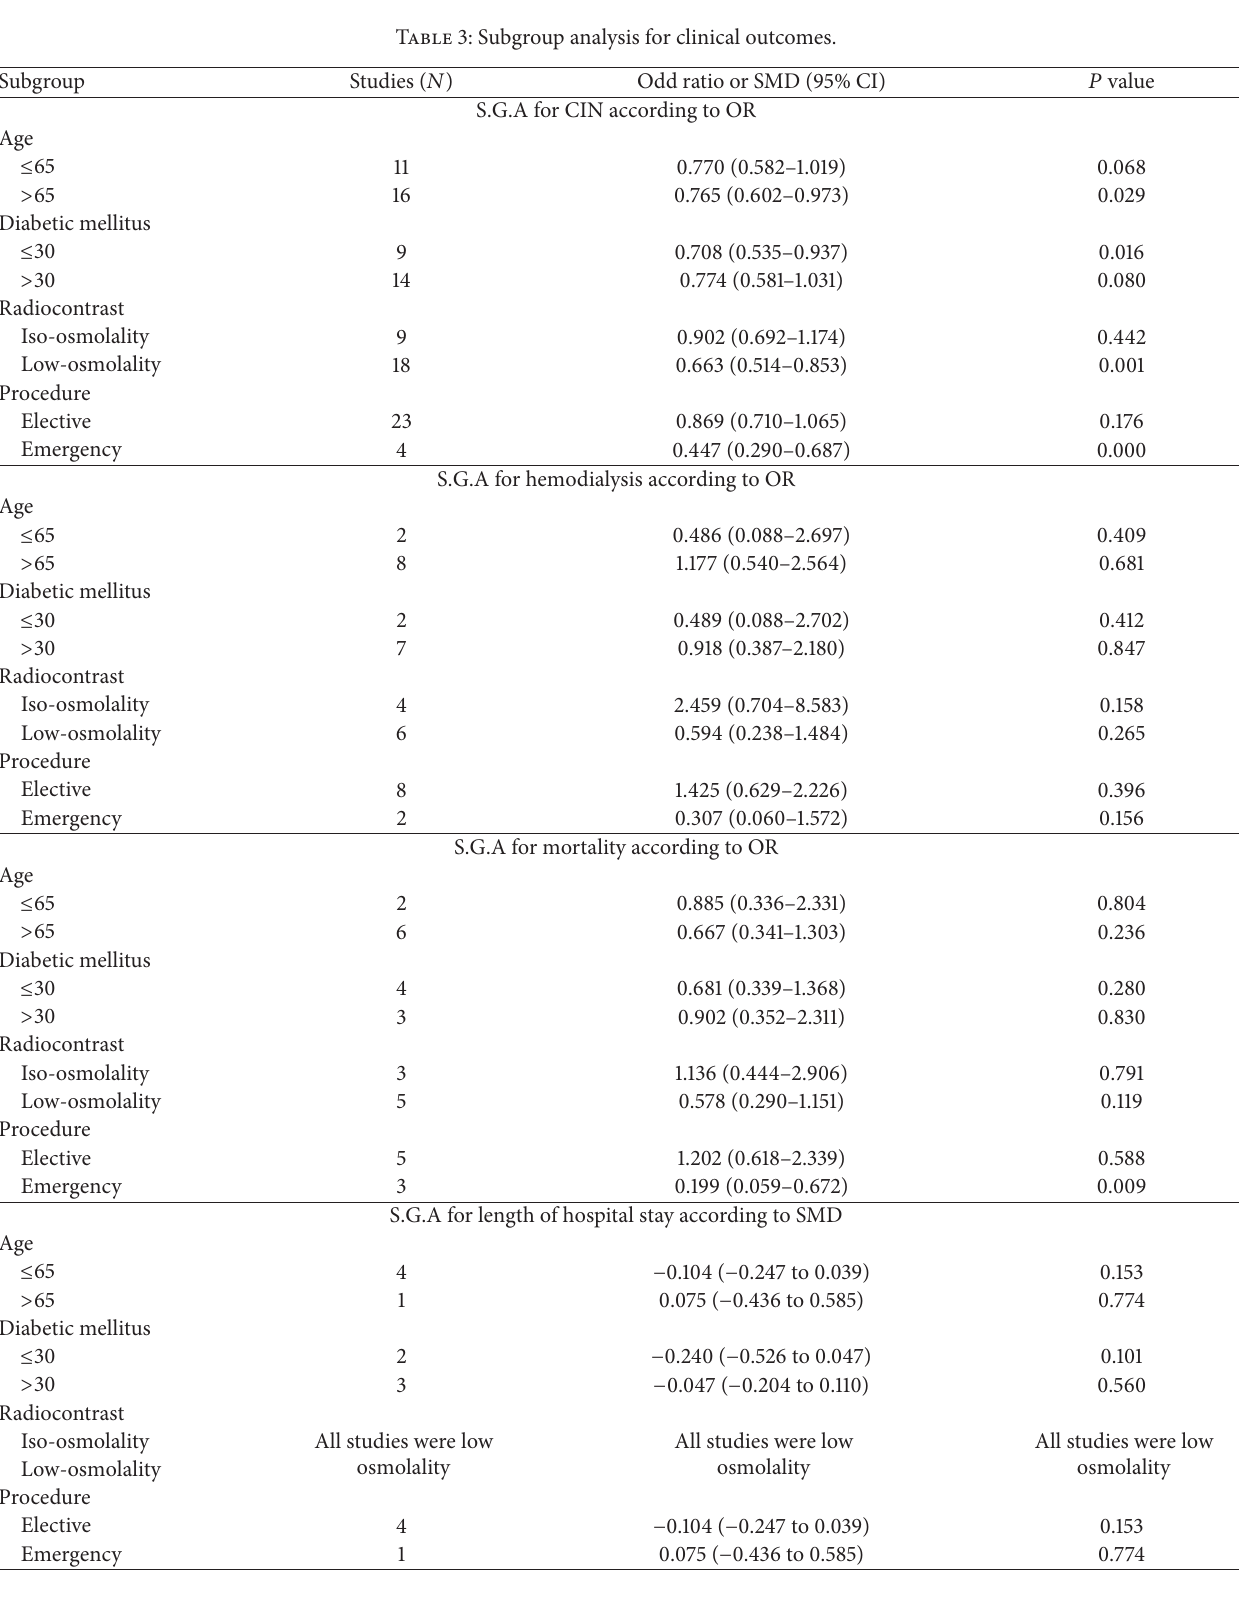
Table 3: Subgroup analysis for clinical